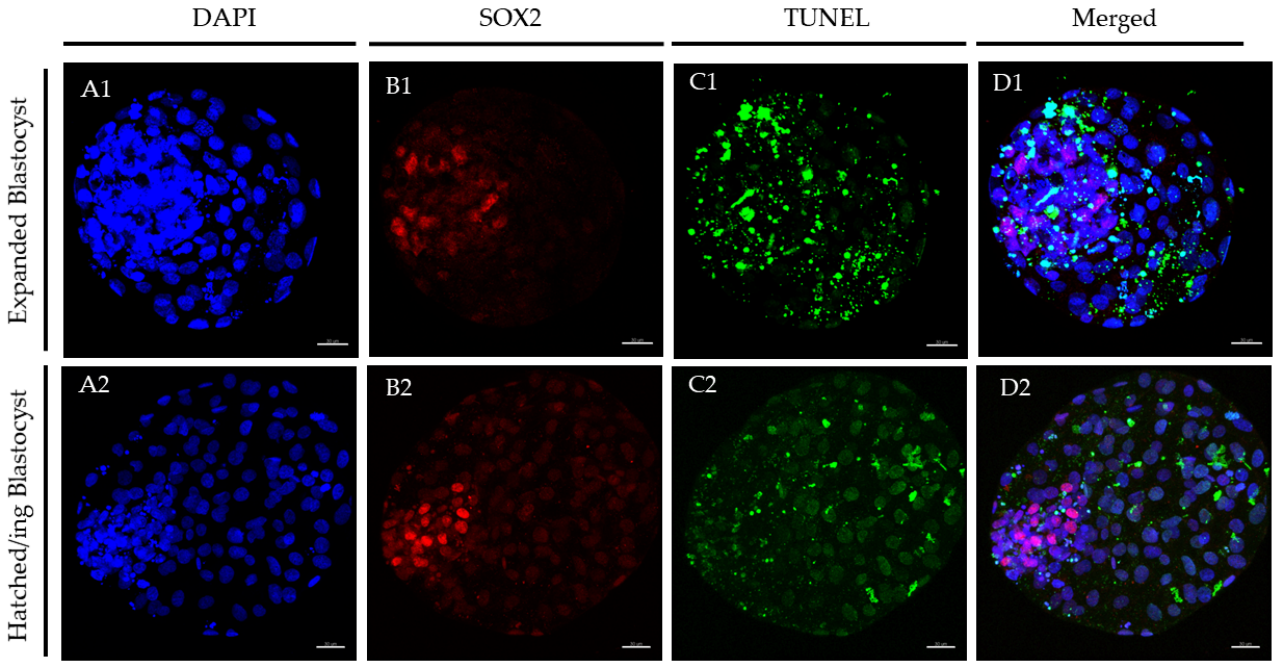
Figure 2. Representative images of post-warmed expanded and hatched blastocysts derived from cow-derived D7 expanded blastocysts vitrified/warmed with vitrification media supplemented with 100 µg/mL EPS ID1. DAPI (blue), SOX2 (red), and TUNEL (green) staining were examined using DAPI, SOX2-Alexa Fluor, and FITC filters, respectively, for total ( A1 , A2 ), ICM ( B1 , B2 ), and apoptotic ( C1 , C2 ) cell counts. An overlay is provided in ( D1 , D2 ). ( A1 , B1 , C1 , D1 ): Expanded blasto- cyst; ( A2 , B2 , C2 , D2 ): Hatched blastocyst. Scale bar = 30 µm. DAPI (406-diamidino-2-phenylindole), TUNEL (terminal deoxynucleotidyl transferase dUTP nick end labelling).